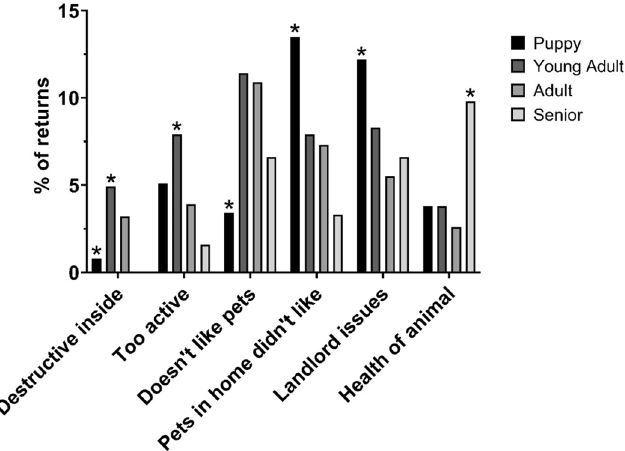
Figure 3. Differences in non-categorized return reasons for dogs based on age group. *Denotes statistical significance ( p <